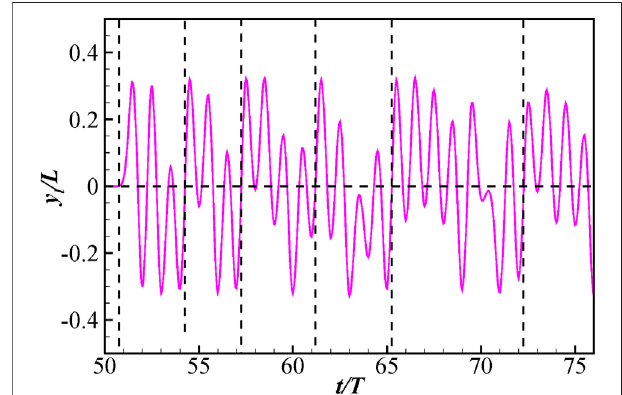
( Figure 9B ). At instants t / T = 53 and t / T = 54 ( Figures 9C,D ), the fi sh is oriented at the reduced streamwise fl ow area. Meanwhile,